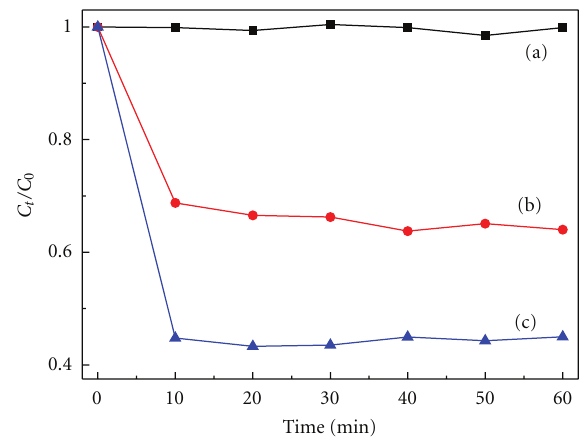
Figure 5: UV-vis di ff use reflectance spectra of bare Ag 3 PO 4 and Ag 3 PO 4 /FLDH composites.